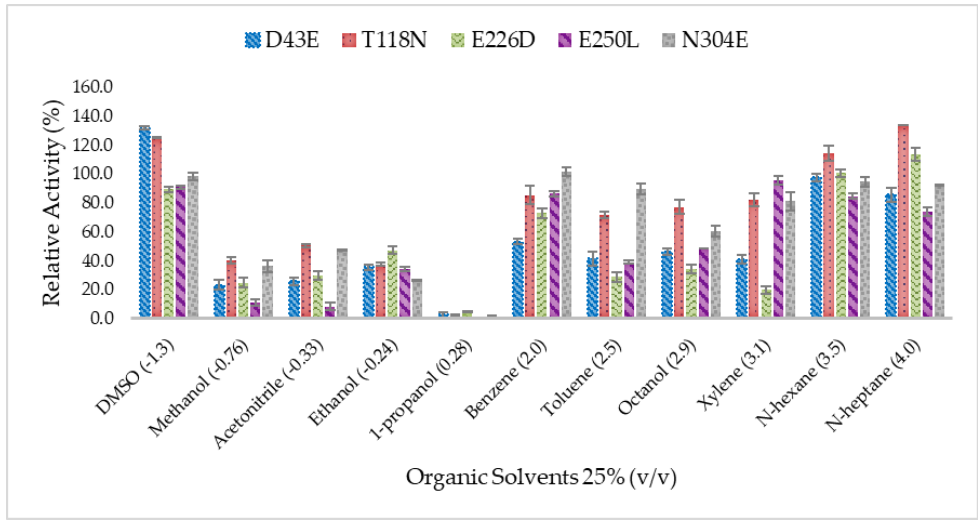
Figure 4. Effect of organic solvents on the catalytic activity of HT1 lipase mutants. The relative activity of each lipase was compared to the untreated lipase without organic solvents. The value of untreated enzyme for each lipase was taken as 100% and not presented in the graph.